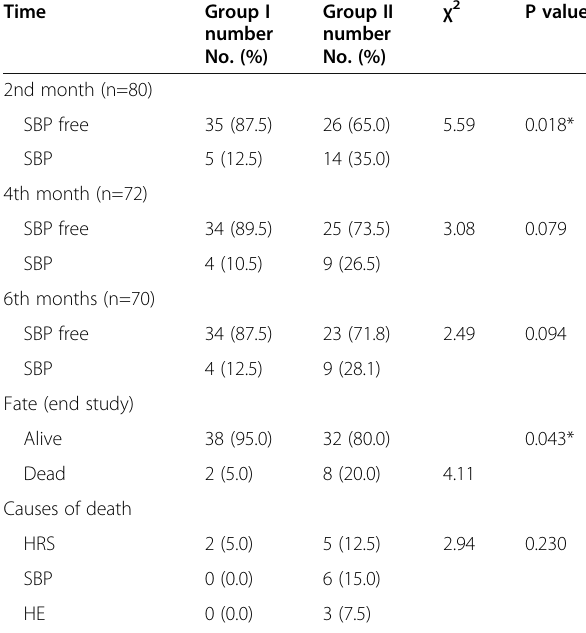
Table 3 Incidence of SBP recurrence and causes of death in both groups